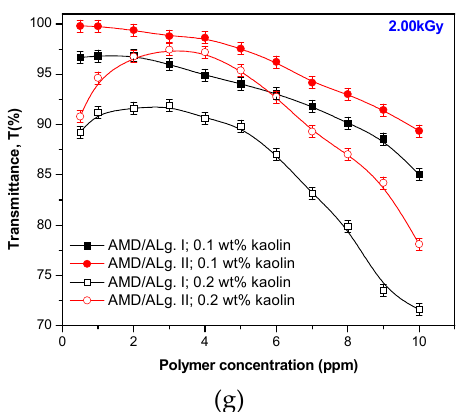
Figure 9. The influence of the polymer type and kaolin concentration on the samples transmittance: AMD/ALg I and II obtained at 0.5 kGy ( a ), 0.75 kGy ( b ), 1 kGy ( c ), 1.25 kGy ( d ), 1.5 kGy ( e ), 1.75 kGy ( f ), and 2 kGy ( g ).